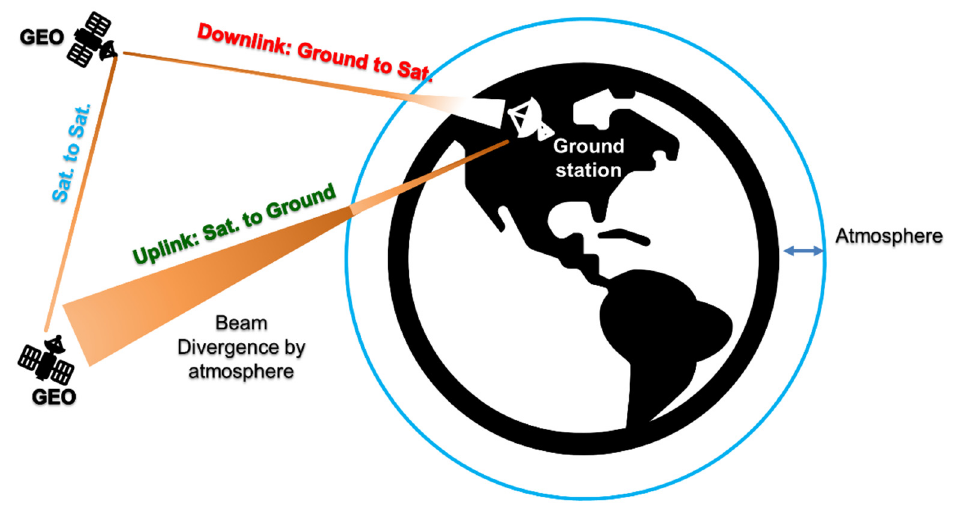
Figure 1. Free space optical (FSO) communications scenarios between geosynchronous equatorial orbit (GEO) satellites and ground station. The KK receivers are compatible with multi-channel systems. If the bandwidth of